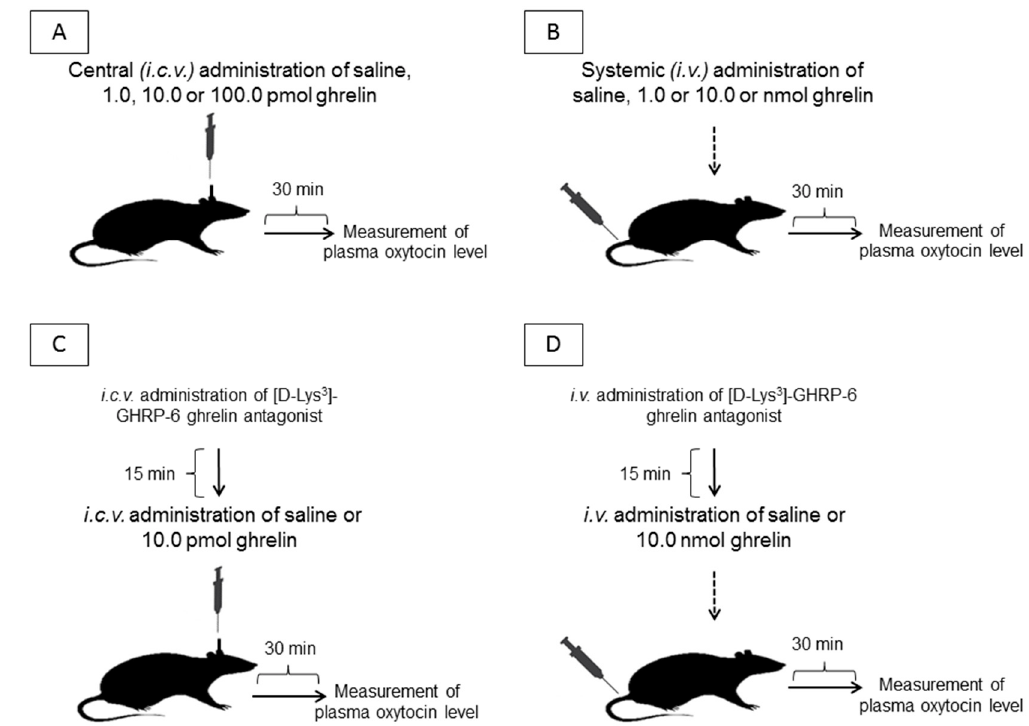
Figure 5. The experimental protocol of the study. i.c.v. = intracerebroventricular/central administration; i.v. = intravenous/systemic administration .